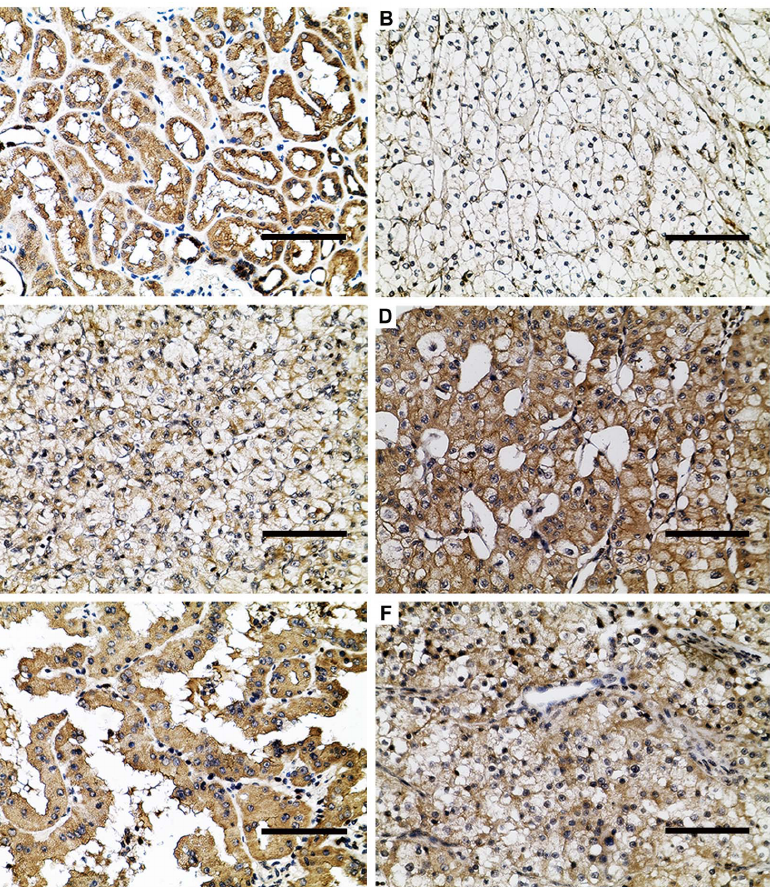
Figure 2. Representative immunostaining for PROX1 in RCC and adjacent normal tissues. Renal tubular epithelial cells showed intense cytoplasmic PROX1 expression (a). RCC tissues showed variable PROX expression; ccRCC showed low (b), moderate (c), or high (d) PROX1 staining. Papillary (e) and chromophobe (f) RCC samples showed high PROX1 expression. Scale bars, 100 m m.